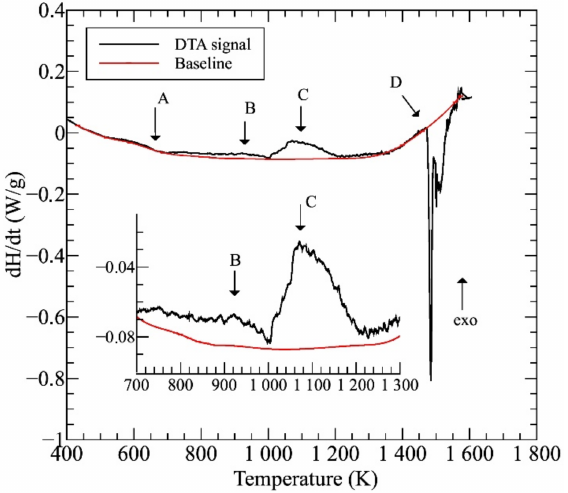
Figure 1. The differential thermal analysis (DTA) thermogram taken on the initial (AC) sample.